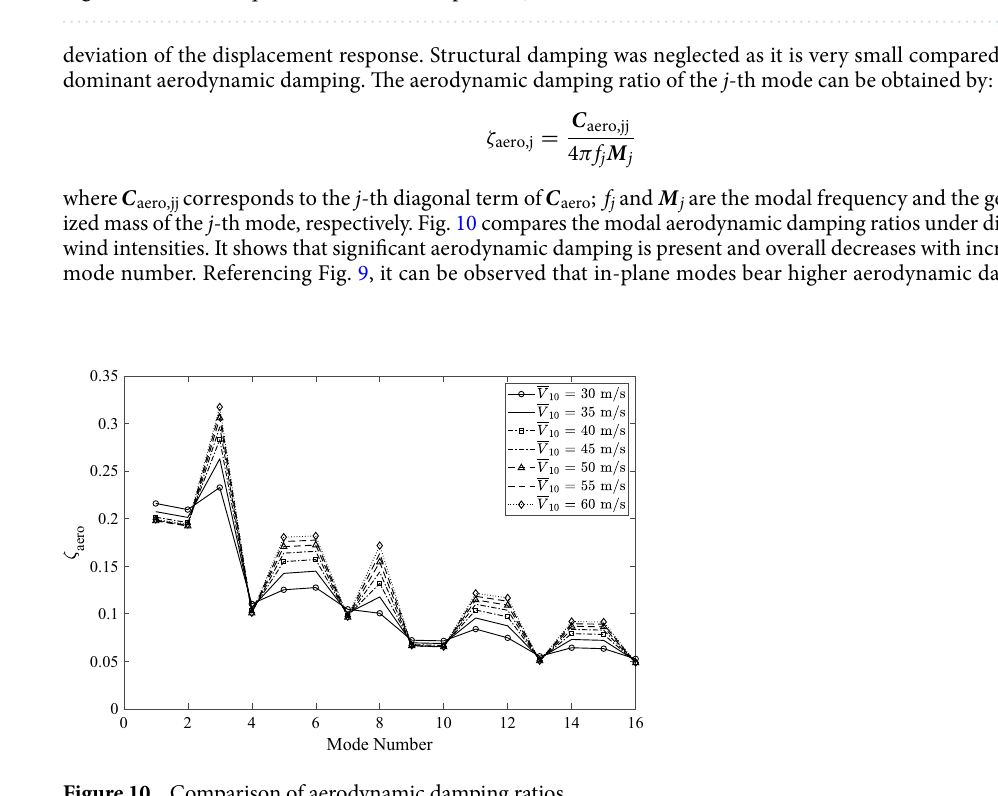
Figure 9. Modal frequencies and mode shapes ( V 10